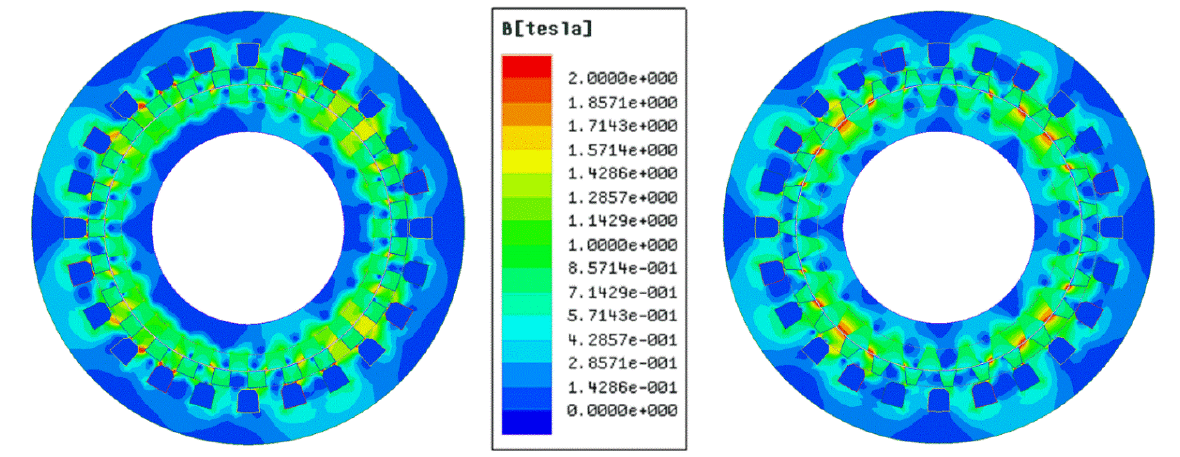
Figure 4. Flux density distribution in the initial case ( left ) and the optimum case ( right ) at no load.